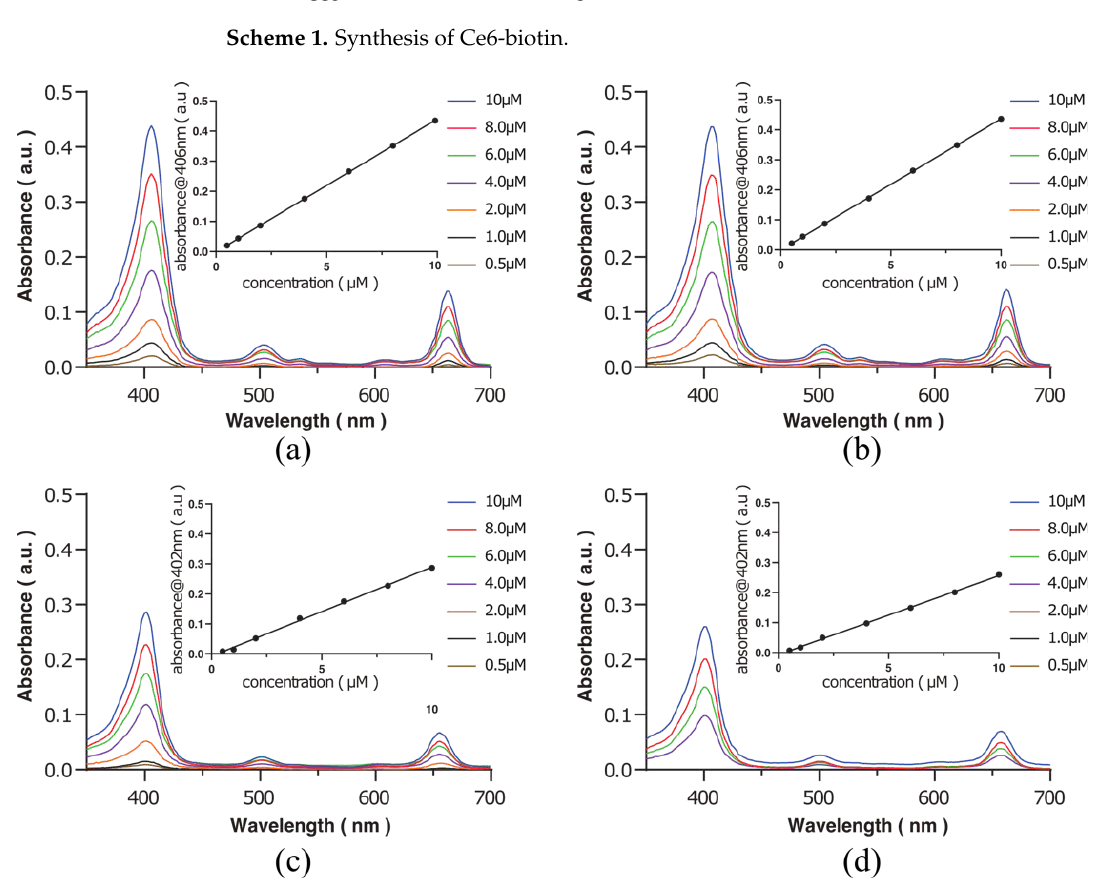
Figure 1. UV-Vis spectra of Ce6 in DMSO ( a ) and PBS ( c ), as well as Ce6-biotin in DMSO ( b ) and PBS ( d ). The insets plot the absorbance of the Q-band versus the concentration of Ce6 and Ce6-biotin.